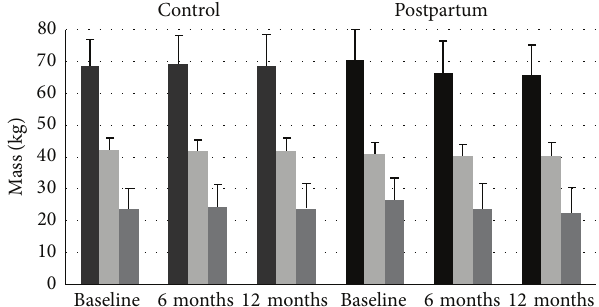
Figure 4: Total body mass (dark gray bars), lean mass (light gray bars), and fat mass (gray bars) at baseline and at 6- and 12-month follow-up in 18 lactating women and 15 never-pregnant control